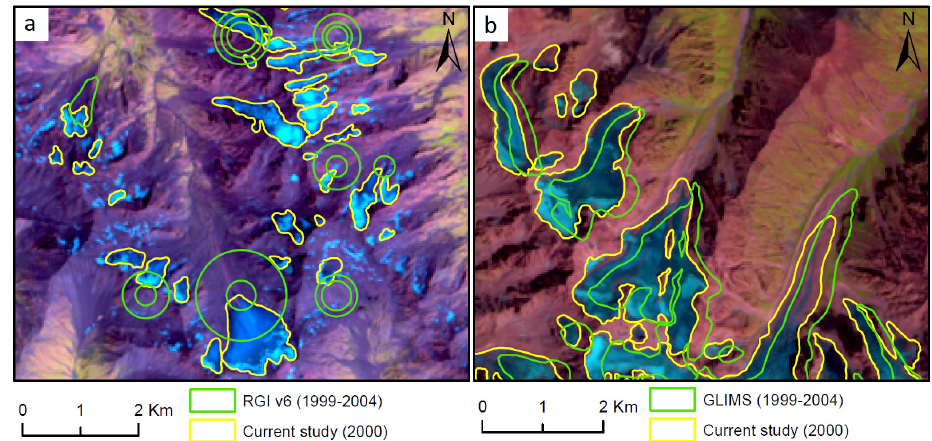
Figure 13. Comparison of glacier outlines from the RGI (v6) and GLIMS (in green) with the outlines from the new Caucasus glacier inventory (in yellow). (a) RGI nominal glaciers (circles) and glacier outlines derived during this study. The 28 July 2000 Landsat 7 image (Table S1) is used as the background. (b) The GLIMS outlines (an example of inconsistent registration) and glacier outlines derived during this study. The 12 August 2000 Landsat 5 image (Table S1) is used as the background. Image credit: https://earthexplorer.usgs.gov (last access: November 2020).